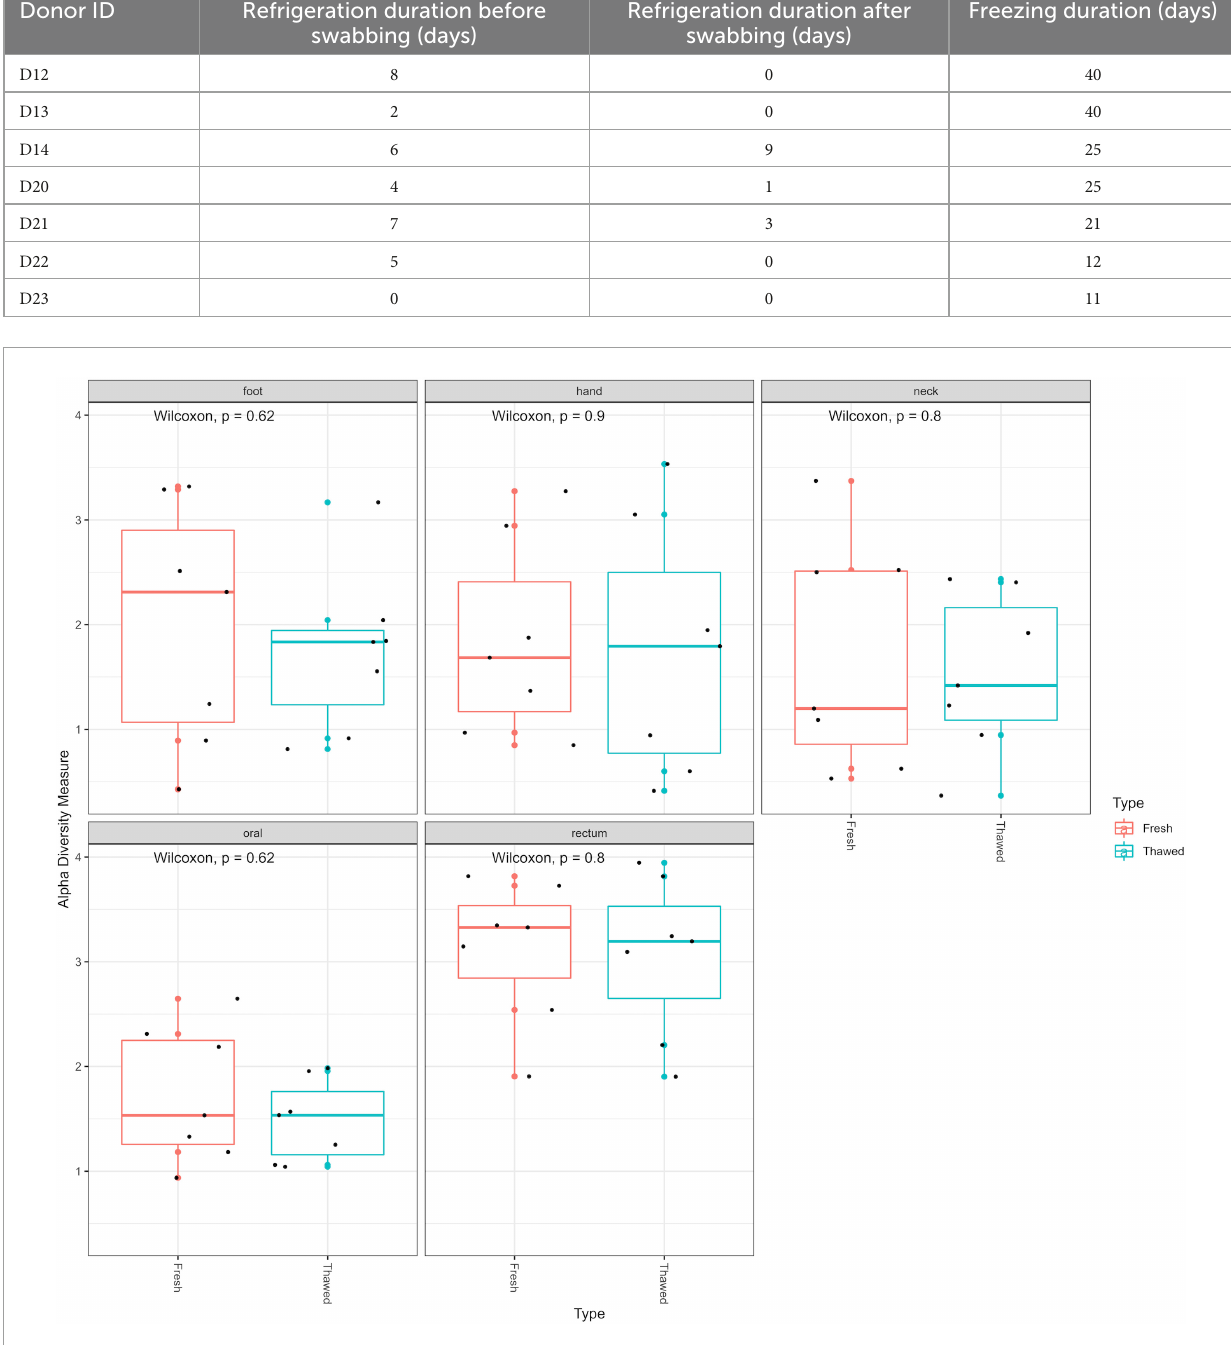
FIGURE1 Alpha diversity plot (Shannon diversity) of fresh and thawed samples per anatomical location at ASV